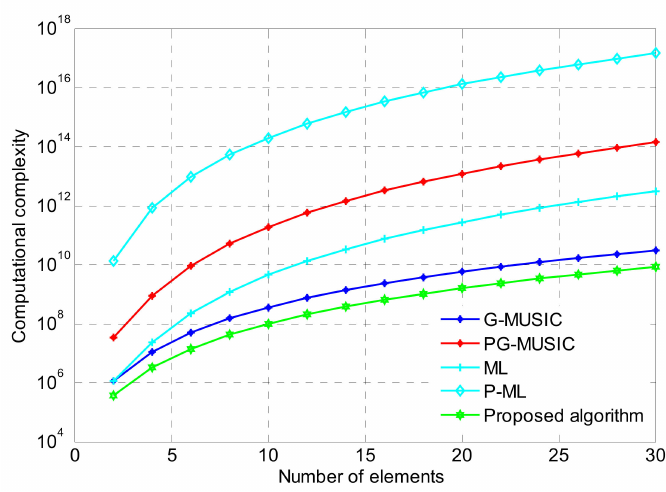
Figure 5. Complexity changes with the array